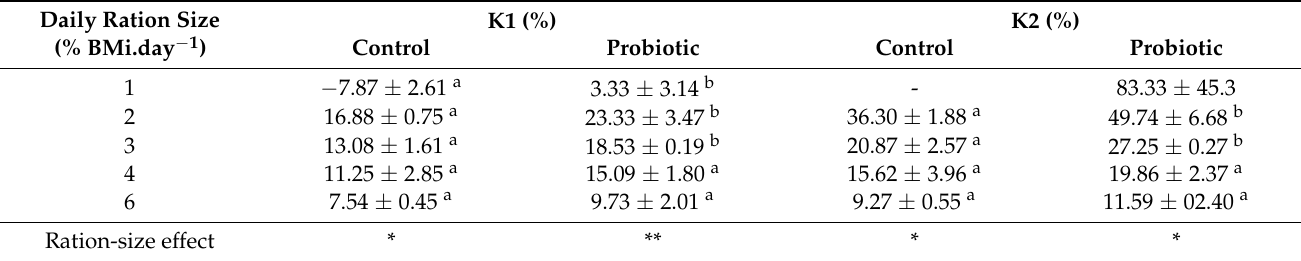
Table 5. Gross (K1) and net (K2) feed conversion efficiency by L. stylirostris per test diet at the ration sizes tested. Mean ± SD, n = 3. For each parameter, different letters within the same raw indicate significant differences between diets (Mann–Whitney test, p < 0.05). The ration size effects were assessed by a Kruskal–Wallis test (n.s., non-significant; * p < 0.05; ** p < 0.01).